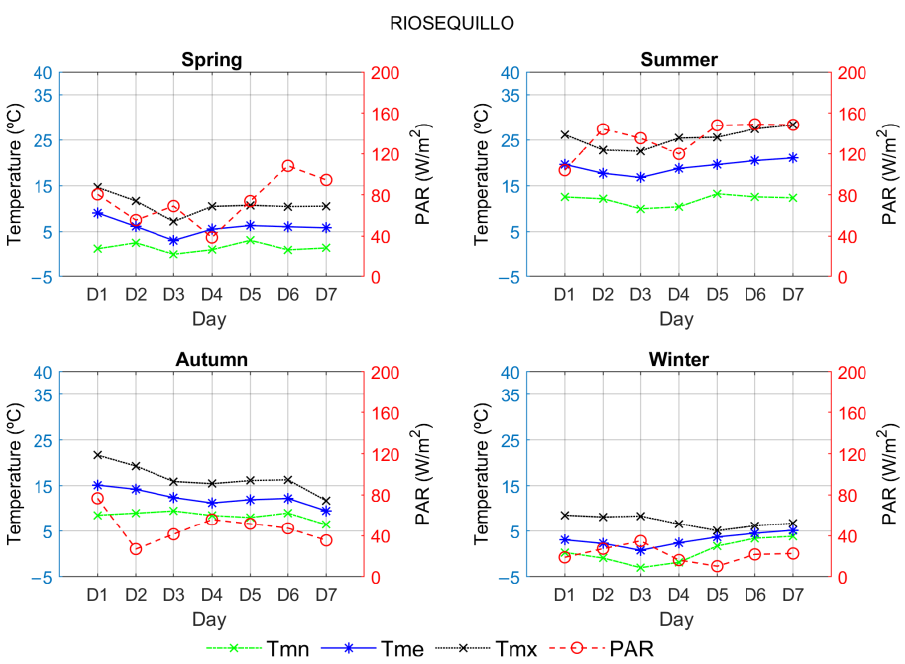
Figure A2. Daily variations of the daily mean values of temperature (mean, max, and min) and PAR for the selected TMWs for each season in Riosequillo from 1991 to 2005.